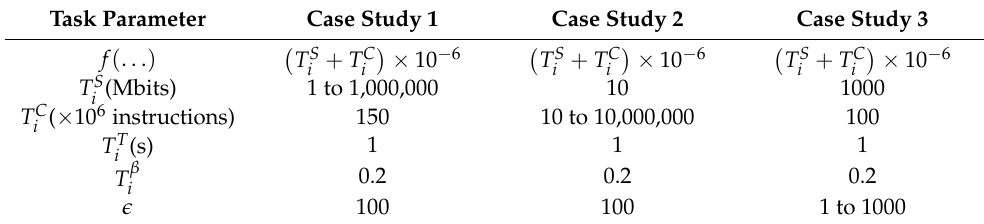
Table 3. Task parameter settings for investigated case